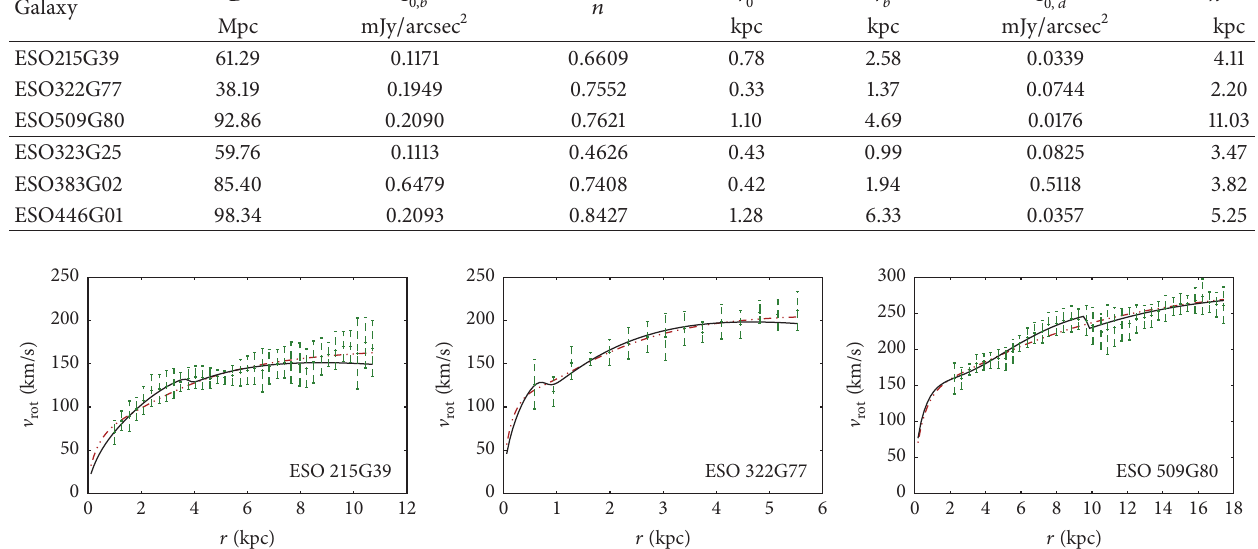
Figure 1: Best fit curves for the HSB I. galaxy sample where the solid black lines hold for the baryonic matter + BEC model, while the dashed red lines refer to the baryonic matter + NFW model.